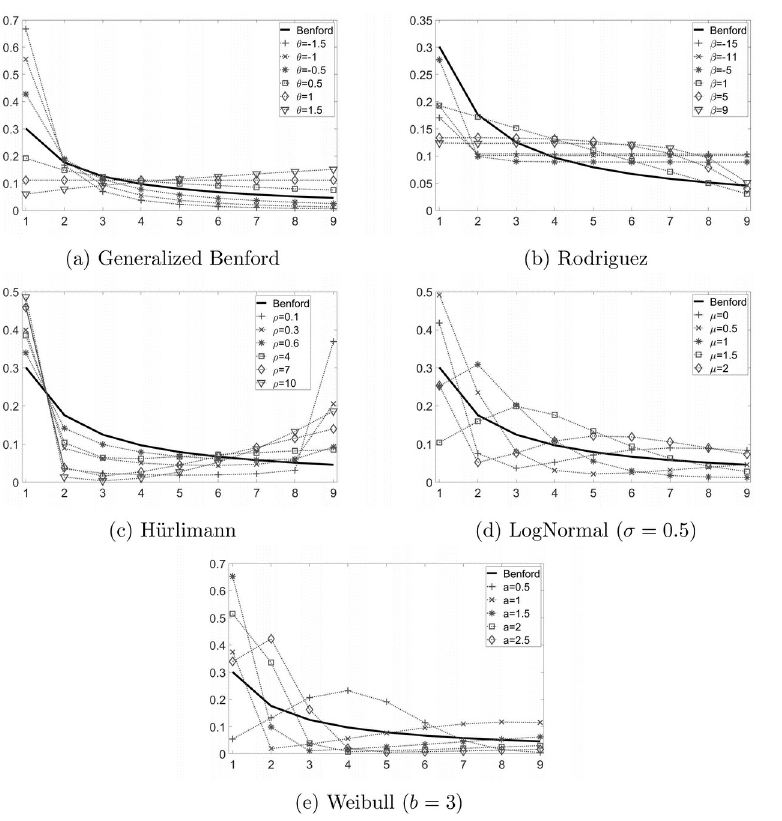
Fig 1. FSD associated to the alternative